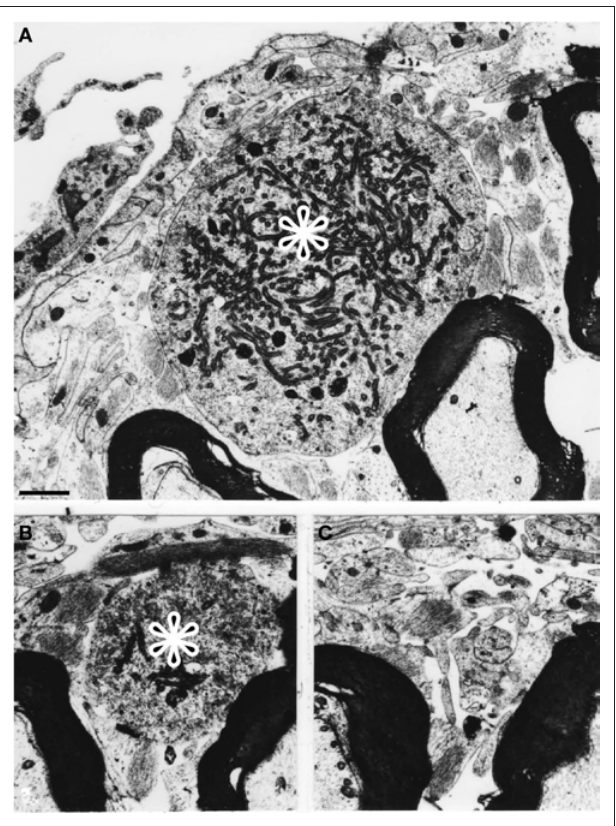
Figure 3 | electron micrographs from a cat surviving for 90 days after the nerve injury. (A) The terminal enlargement of an unmyelinated axon is shown (indicated by the asterisk). Proximally the axon became gradually smaller (B) and was not longer present at the level illustrated in (C) . (magnification in A–C ) Scale bar = 1